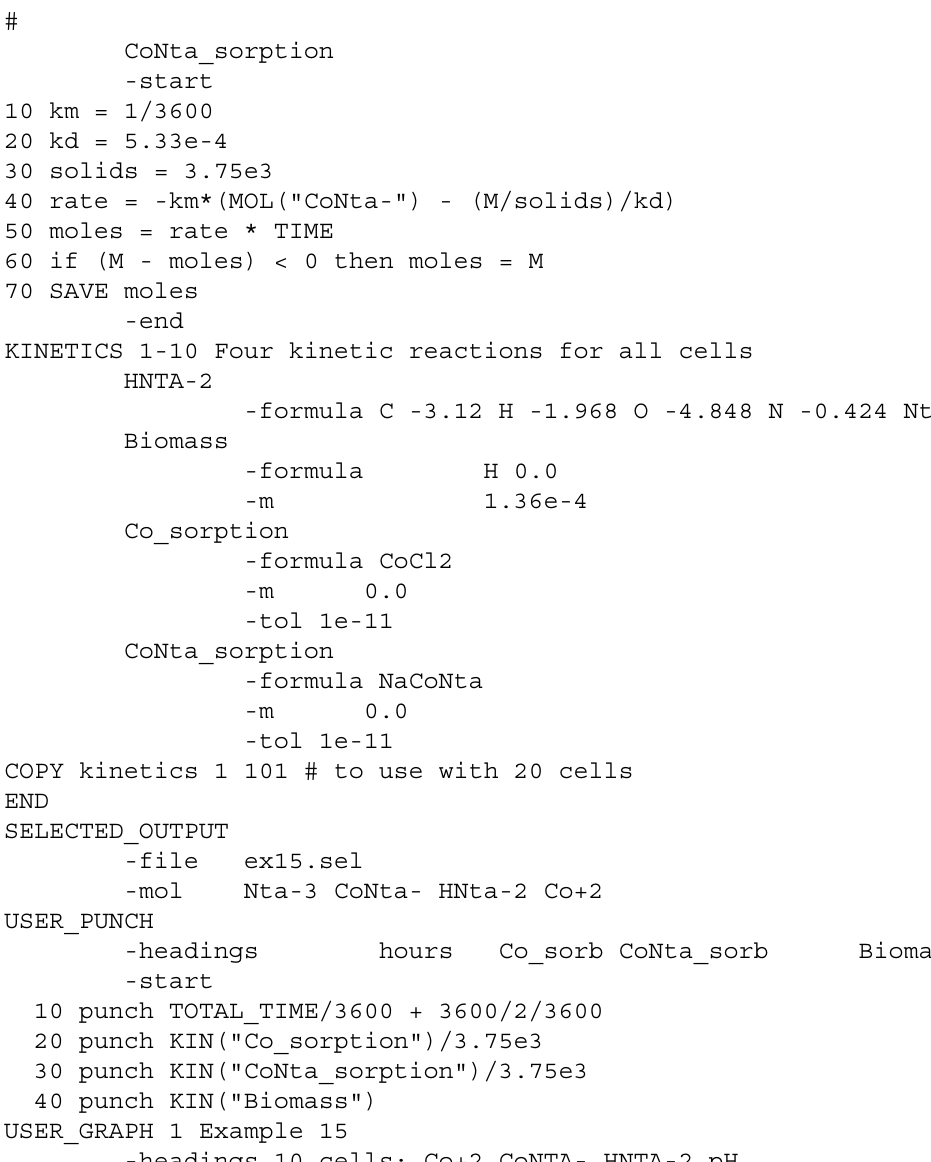
-headings 10_cells: Co+2 CoNTA- HNTA-2 pH